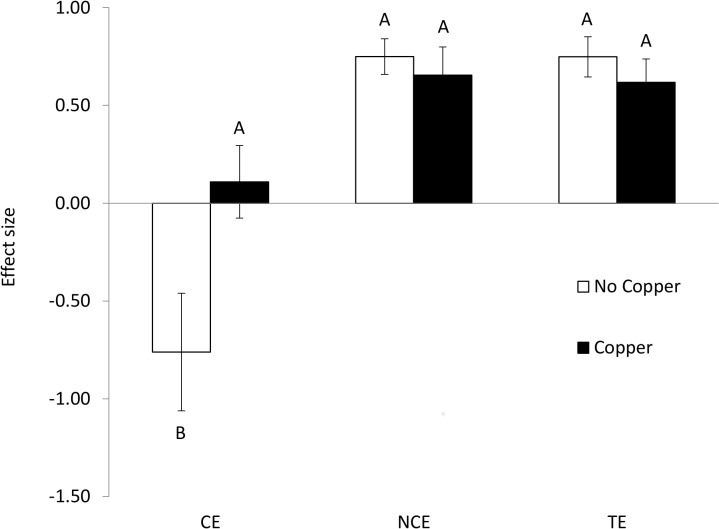
Effects of copper and crab predator effect type on whelk consumption rates.Mean (±SEM) effect size of crab predator Consumptive Effects (whelk culling, CE; n = 5), Non-Consumptive Effects (crab cues, NCE; n = 5), and Total Effects (crabs cues and whelk culling, TE; n = 5) calculated with per capita whelk consumption of barnacles. Empty bars represent No Copper treatments (n = 5). Filled bars represent 50 ppb Copper treatments (n = 5). Different letters indicate significantly different groups (Tukey HSD tests, p < 0.05).